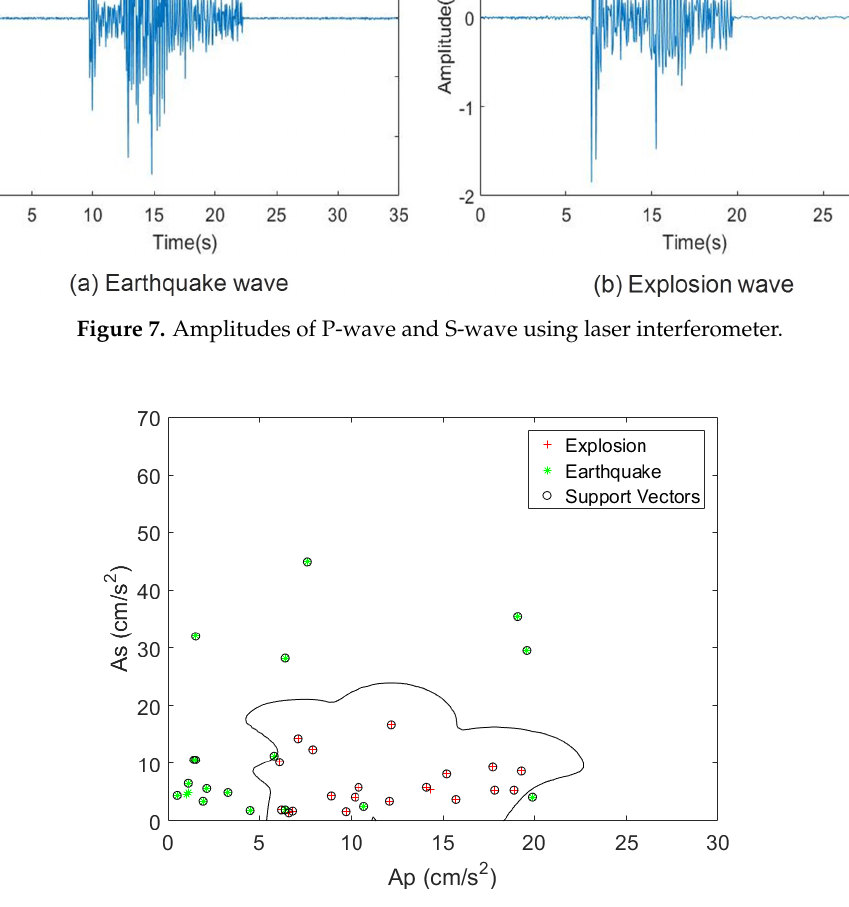
Figure 8. SVM classifier with RBF kernel function ( σ = 0.14) using laser